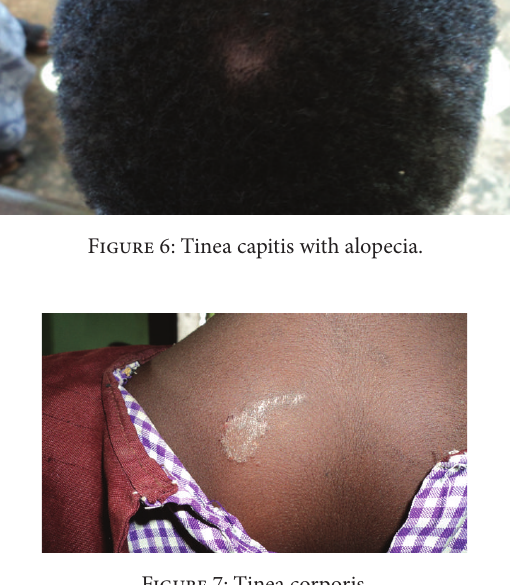
Figure 7: Tinea corporis.